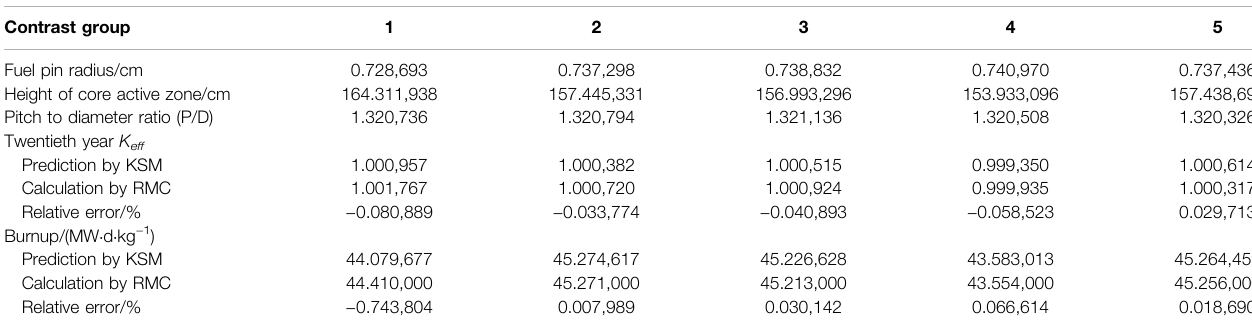
TABLE 7 | Accuracy veri fi cation results of KSM for predicting K eff and burnup. Contrast group